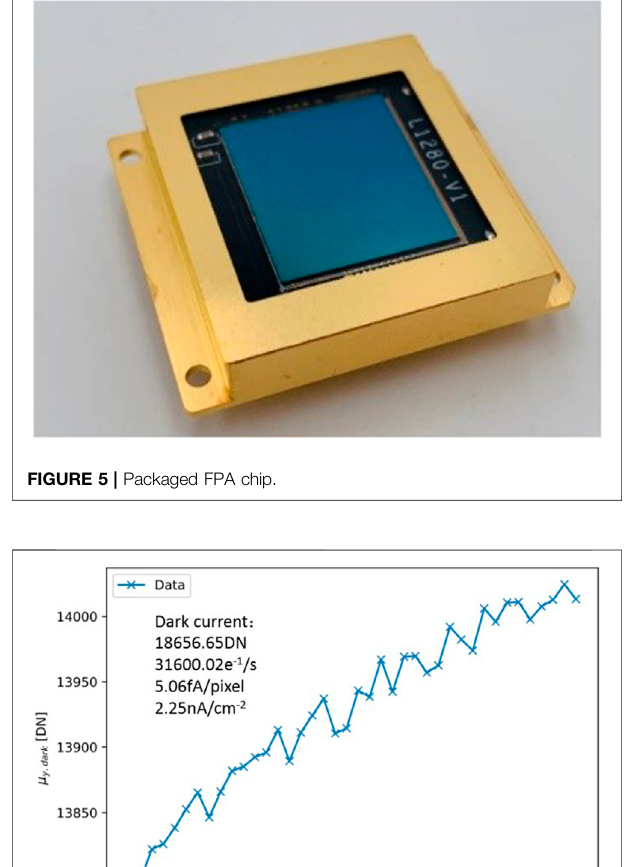
Frontiers in Physics |